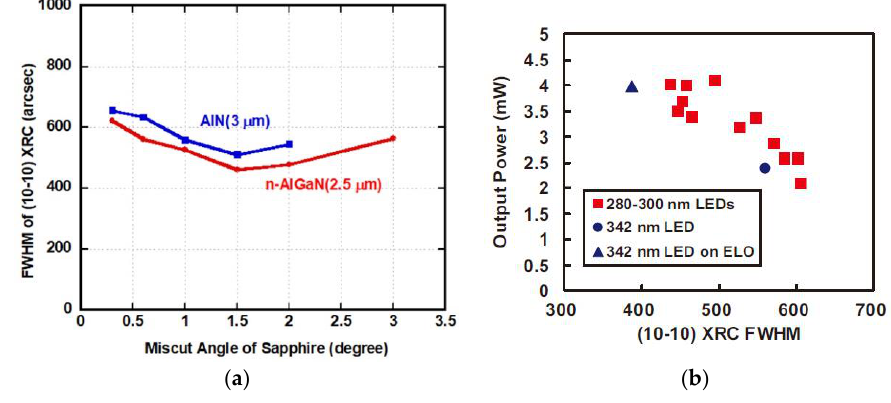
Figure 3. ( a ) Relationship between FWHM of XRC (10-10) for AlN and AlGaN on AlN templates